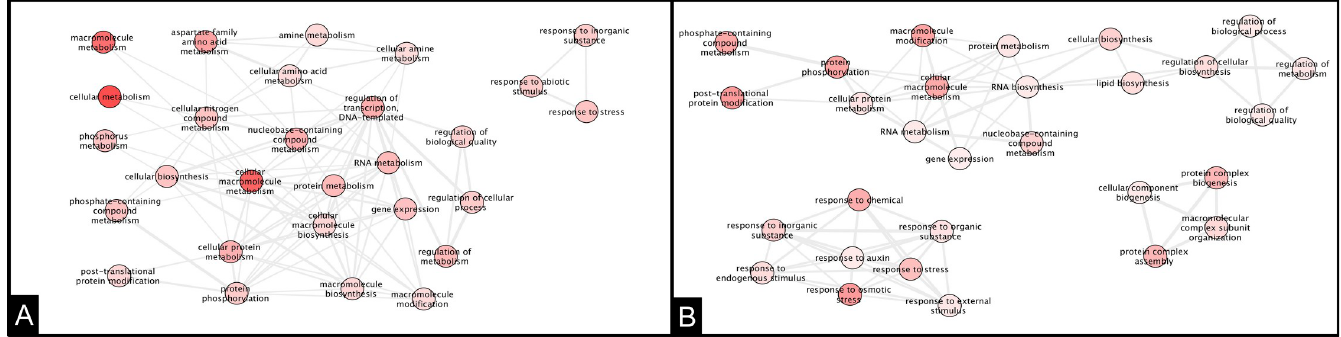
Fig 6. Interaction network of DEG in oil palm clones at 24 hpi of infection. A: Ortet 34 resistant B: Ortet 57 susceptible.